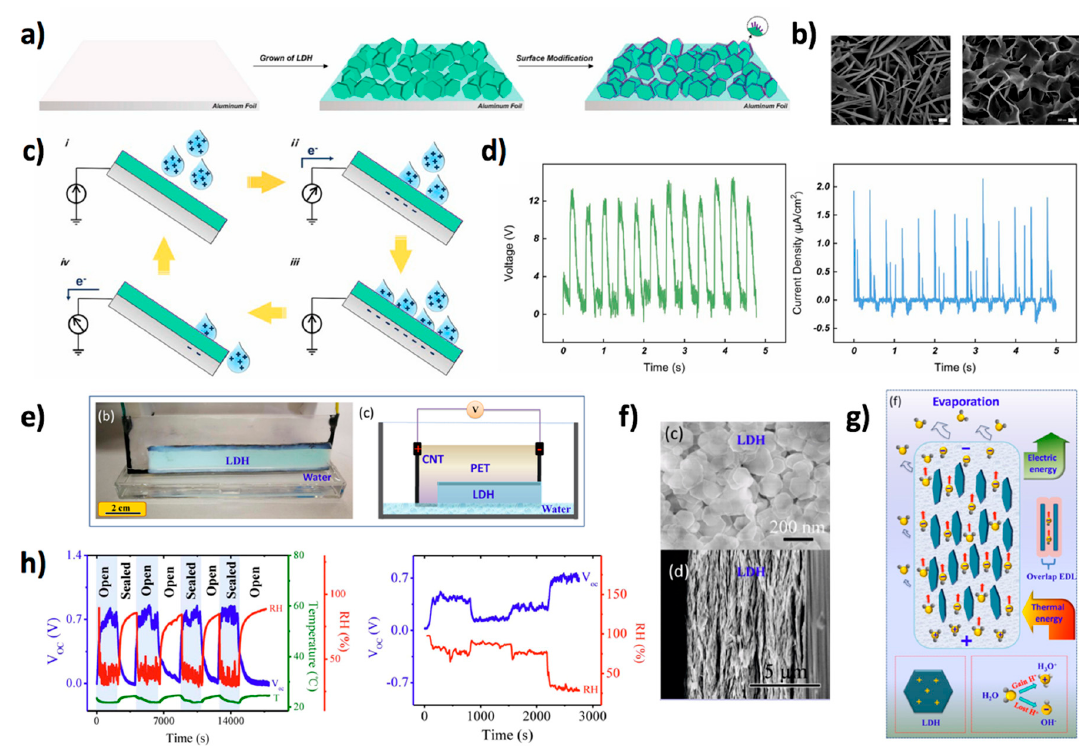
Figure 10. LDH-based water driven nanogenerators. ( a ) Schematic illustration of the fabrication process for the LDH-based triboelectric layer of the WD-TENG, showing (from left to right) the bare aluminum foil substrate and the MgAl-LDH nanosheet network before and after surface modification .